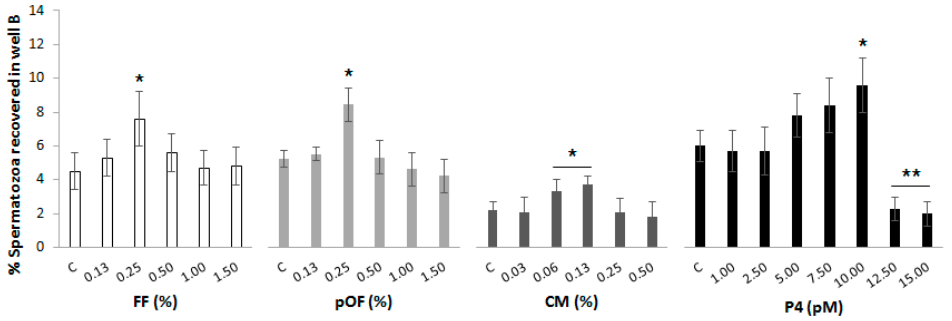
Figure 2. Effective concentration of chemoattractants. Increasing concentrations of the chemoattractants were added to well B of the chemotactic system. A group in which there was not a supplementation of any chemoattractant in well B was included as control (C) for each chemoattractant. Spermatozoa were added to well A in a concentration of 20 × 10 6 spermatozoa/mL. The system was incubated for 20 min, 38 ◦ C, 5% CO 2 and 95% humidity. The results are expressed as the percentage of spermatozoa recovered in well B. The most effective concentration of each chemoattractant was established as the lowest concentration that attracted the highest proportion of spermatozoa. Four replicates were performed. Asterisks (*, **) indicate statistical differences between groups within the same chemoattractant ( p <